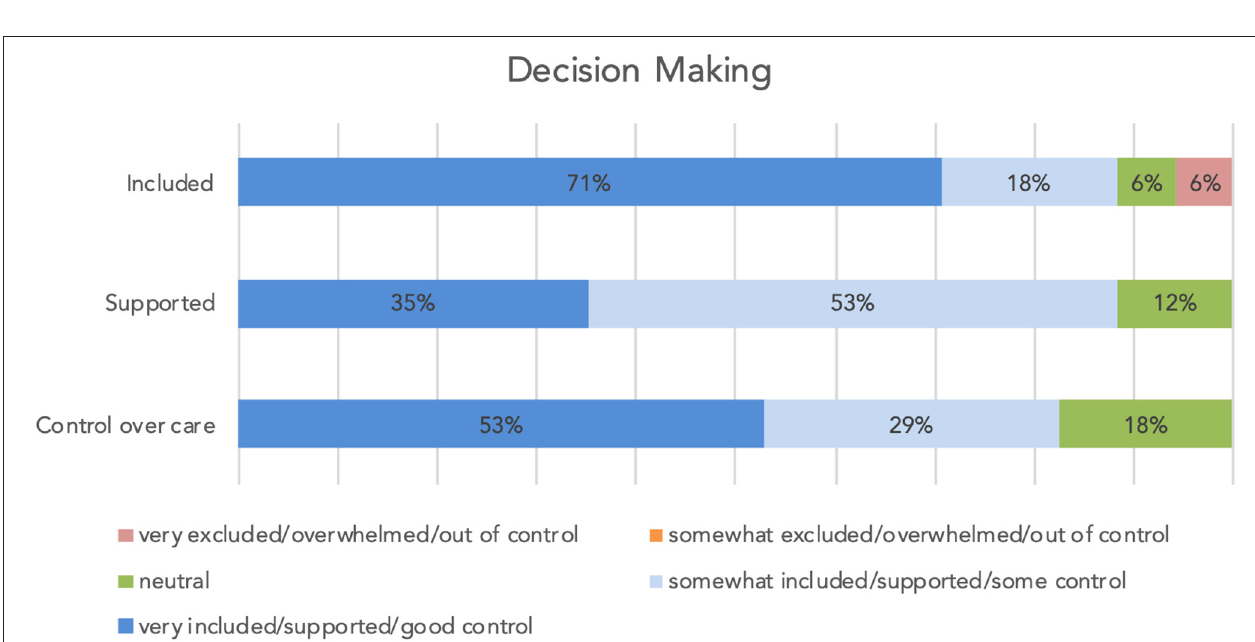
FIGURE 2 | Decision making: included in the decision process, supported during the decision process, control over the care the patient received.